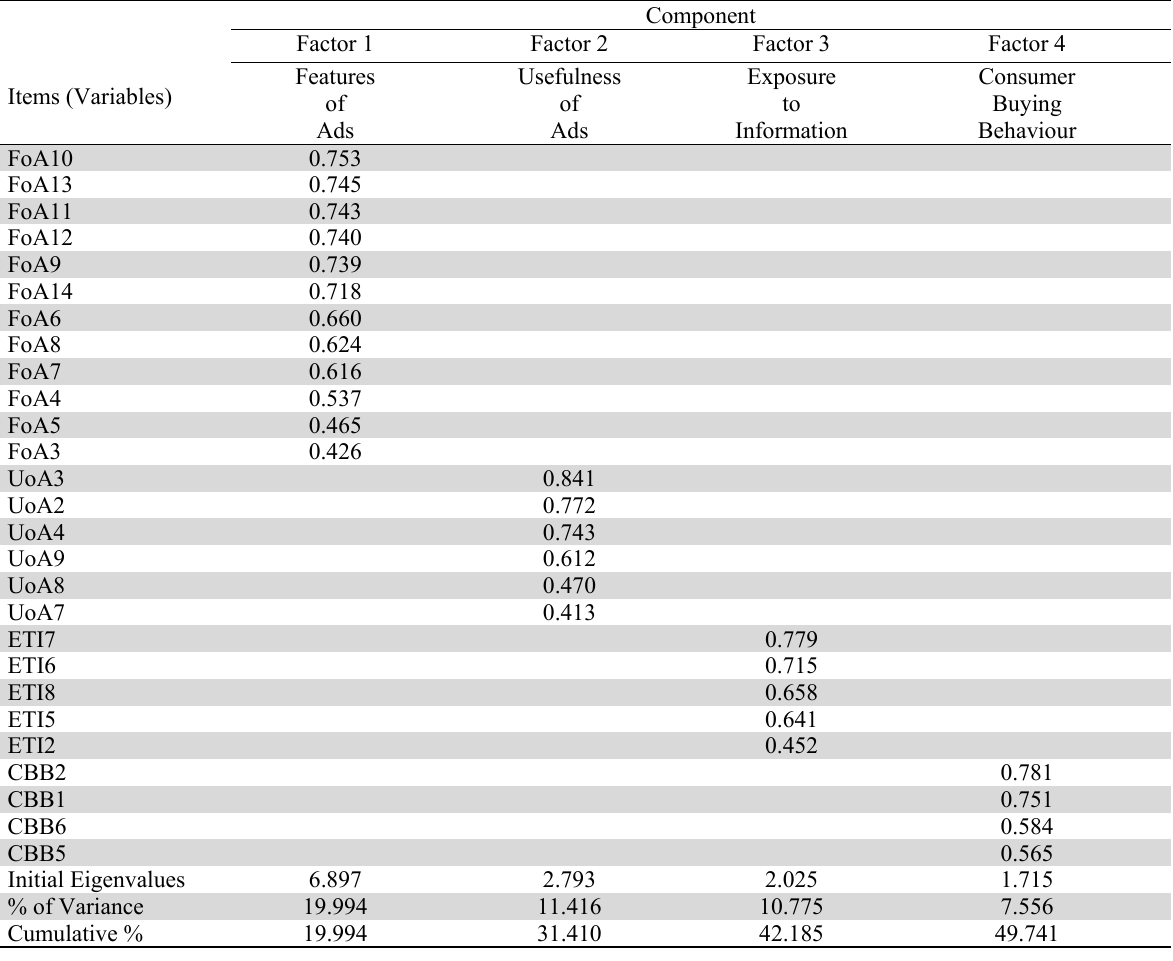
Results of Factor